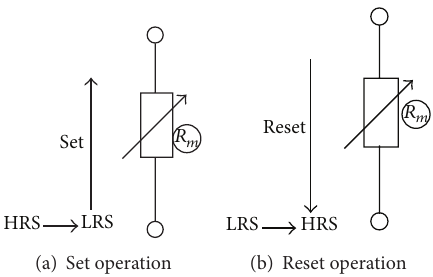
Figure 1: Current flow of the set and reset operations of ReRAM (bipolar switching device).